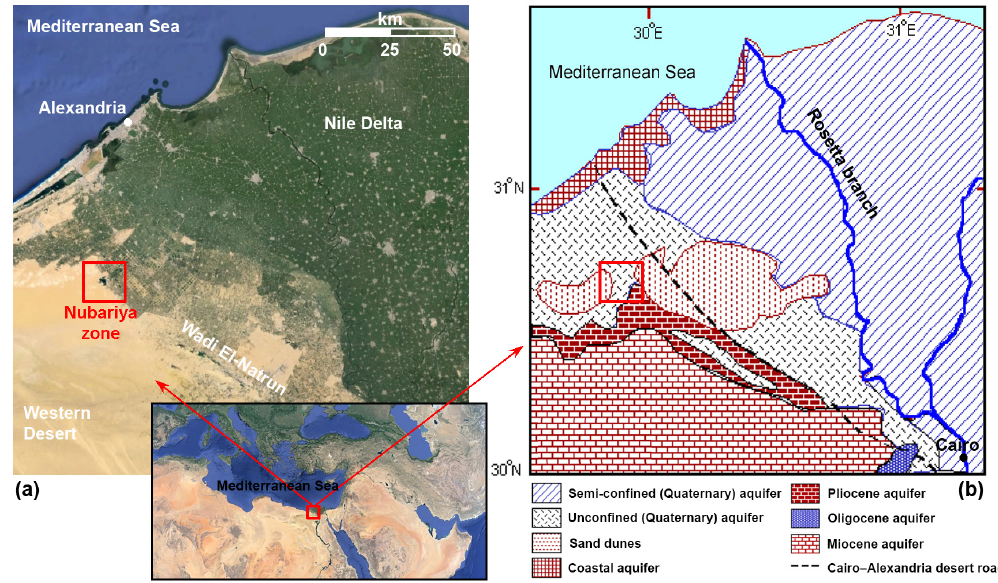
Figure 1. (a) The location map of the Nubariya depression between the Western Desert and the western Nile Delta in Egypt and a Landsat image available from the US Geological Survey. (b) A map showing the main hydrogeological and aquifer units (modified after Sharaky et al.,